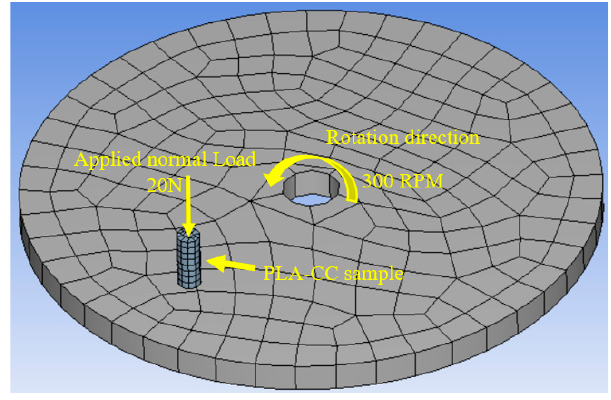
Figure 4. The finite element model of the frictional process.